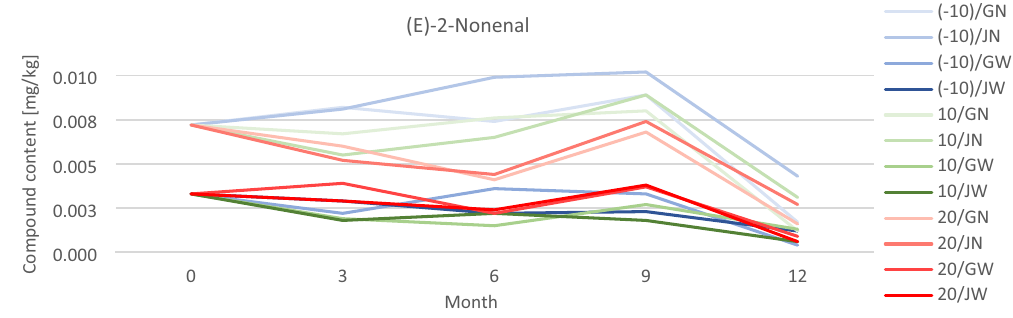
Figure 7. The content of (E)-2-Nonenal in tested green coffee samples on a 12-month basis (with results recorded every 3 months), after appropriate treatment in packaging